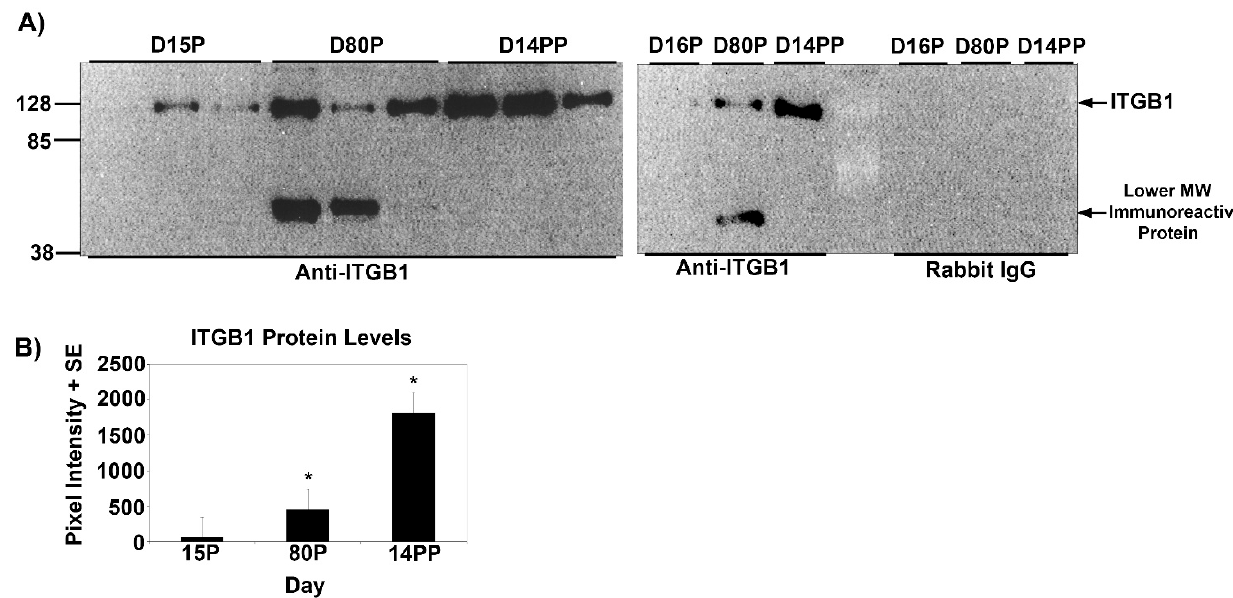
Figure 2. ( A ) Western blot detection of the beta 1 integrin (ITGB1, 8% 1D-PAGE) in ovine myometrial extracts (10 µg/lane) from different Days of pregnancy (P) or postpartum (PP). Each lane represents a sample from a different ewe. Immunoreac- tive proteins were detected using a rabbit anti-ITGB1 IgG or irrelevant rabbit IgG. The positions of pre-stained molecular weight standards are indicated on the left of the gels. ( B ) Quantification of total ITGB1 protein in myometrial tissue as detected by Western blotting. ITGB1 protein increased on Day 80 of gestation, and expression remained elevated through Day 14 postpartum, as indicated by the asterisk ( p < 0.05).